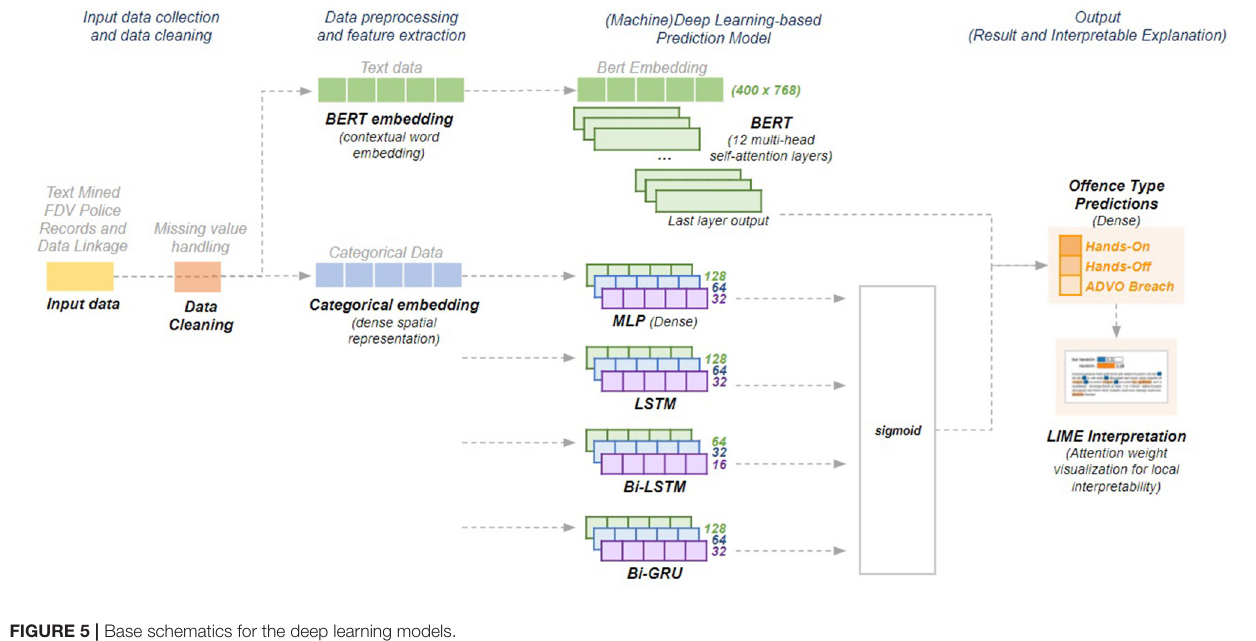
FIGURE 5 | Base schematics for the deep learning models.